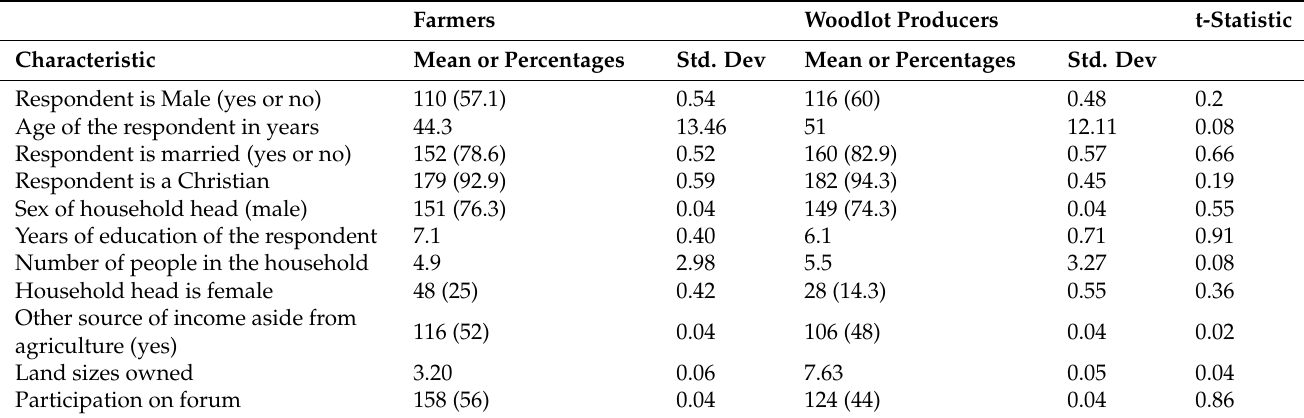
Table 2. Demographic and socio-economic characteristics of respondents. Farmers Woodlot Producers